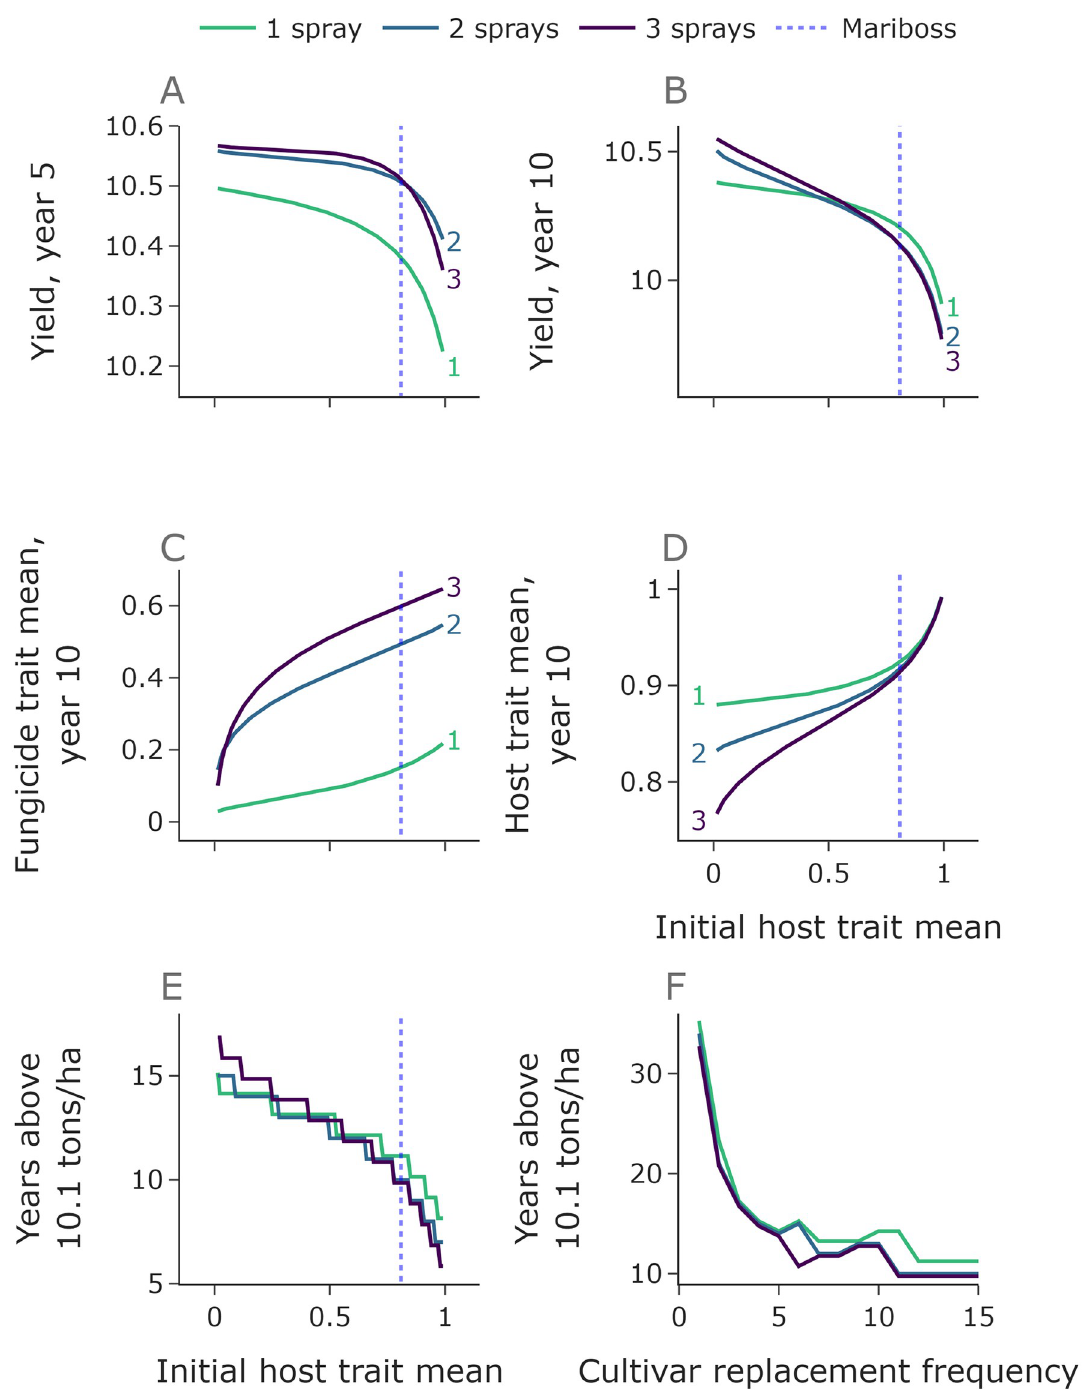
Fig 6. More effective cultivars protect fungicides more strongly and more frequent replacement leads to effective control for longer. In panels A - E we vary the initial host trait mean whilst keeping the shape parameter fixed. The vertical dotted lines show the fitted trait mean value for ‘Mariboss’. Lower host trait means than this value represent hypothetical cultivars which are even more disease-resistant. Over a short timescale (5 years) more applications is preferable than only one ( A ). However, for longer timescales and initial trait values close to that of ‘Mariboss’ (dotted line) one application outperforms two and three. For a given number of fungicide applications per year, the stronger the host protection (lower trait values), the slower the fungicide resistance develops ( C ). For a given initial host strength, higher numbers of fungicide applications protects the host more effectively ( D ). One application keeps the yield above a threshold of 10.1 tons/ha for the longest for all initial host trait values greater than 0.56 ( E ). Each year value is an integer but